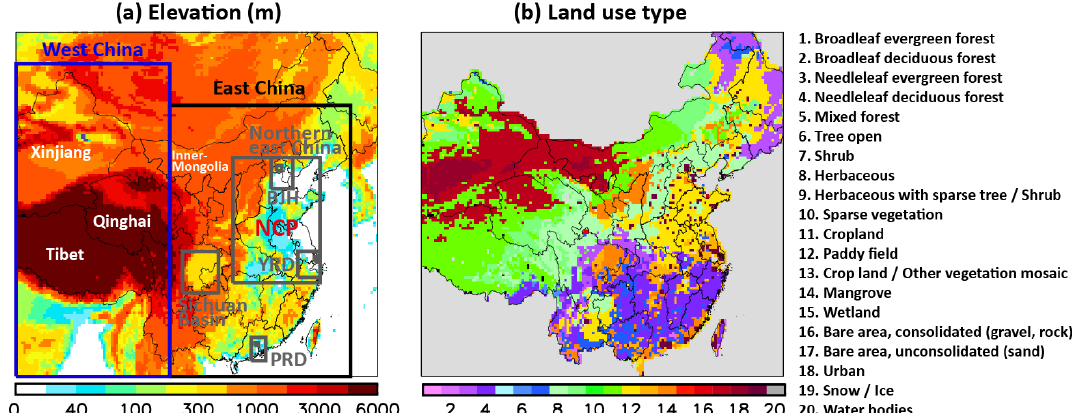
Figure 1. (a) USGS GMTED2010 surface elevation and (b) ISCGM GLCNMO land use types mapped to a 0.25 ◦ long. × 0.25 ◦ lat. grid. Provincial boundaries of China are shown. Urban land use type is highlighted in (b) , such that a grid cell is designated as “urban” if at least 5% of its land is covered by urban areas. Also indicated in (a) are provinces (in white) and regions (in various colors) mentioned in the text. Eastern China: 101.25–126.25 ◦ E, 20–46 ◦ N; western China: 80–101.25 ◦ E, 20–50 ◦ N; northern eastern China: 110–122 ◦ E, 29–41 ◦ N;